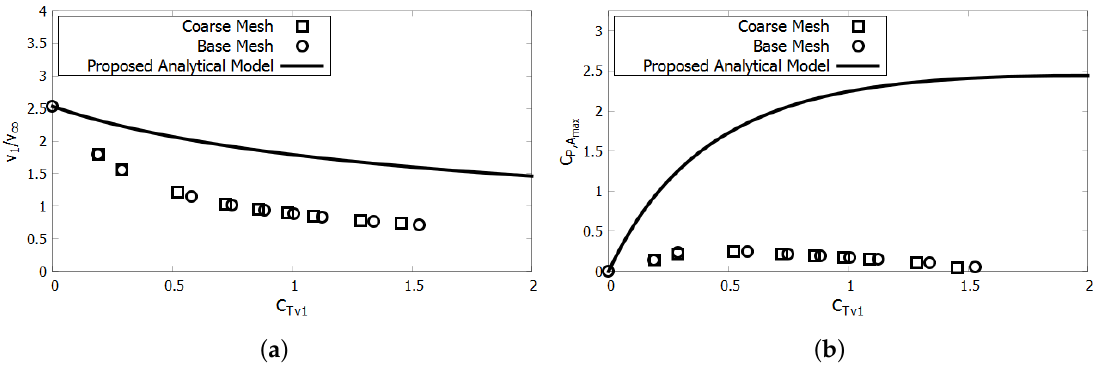
Figure 10. Analytical model and ducted CFD predictions. ( a ) v 1 / v ∞ vs. C Tv